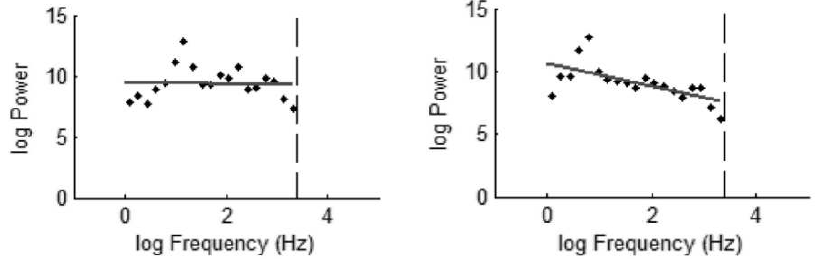
Figure 7. Plots of log power x log frequency for sawing